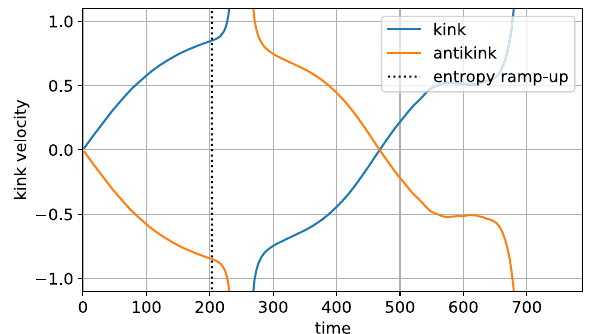
FIG. 26. Kink and antikink wavepacket velocity for simula- tion (ii), computed as the finite difference of the interpolated position of the 0-intercept of (cid:2) Z j (cid:3) . The bond dimension is 128. The interpretation of the 0-intercept as the position breaks down both during and, to some extent, after the collision: during the collision, the zero intercept disappears altogether as the kink and antikink merge and all spin expectation values are > 0. After the collision, there are in this case (see Fig. 10) at least two different bubble “branches” of the wavefunction, both contributing to the spin expectation values. The onset of the first collision is indi- cated by the dotted line, which is the time at which the maximum cut entropy begins to grow rapidly.